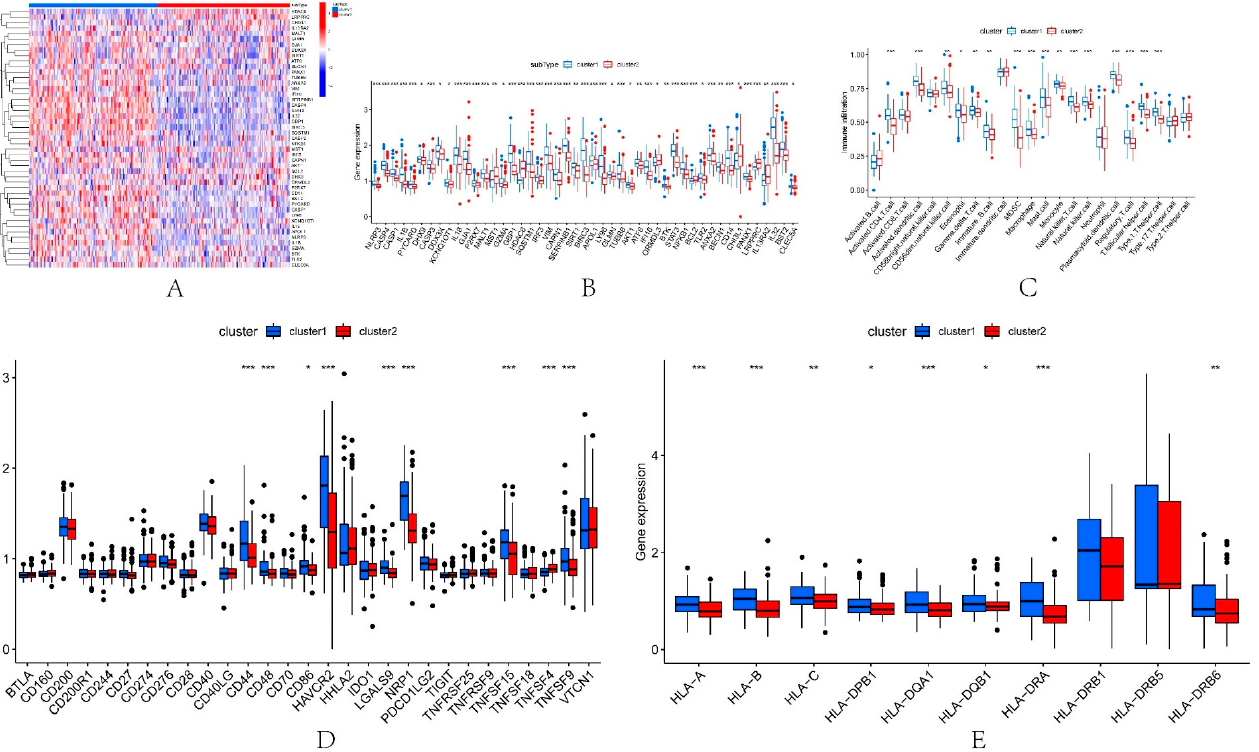
Figure 5. Immune features in the two pyroptosis-related clusters. Heatmap ( A ) and boxplot ( B ) of 47 DEPRGs in the typing dataset. ( C ) The difference in the abundance of immune cells between cluster1 and cluster2. ( D ) Expression differences between cluster1 and cluster2. ( E ) Expression differences of HLA-related genes between cluster1 and cluster2. * p < 0.05, ** p < 0.01, *** p < 0.001.